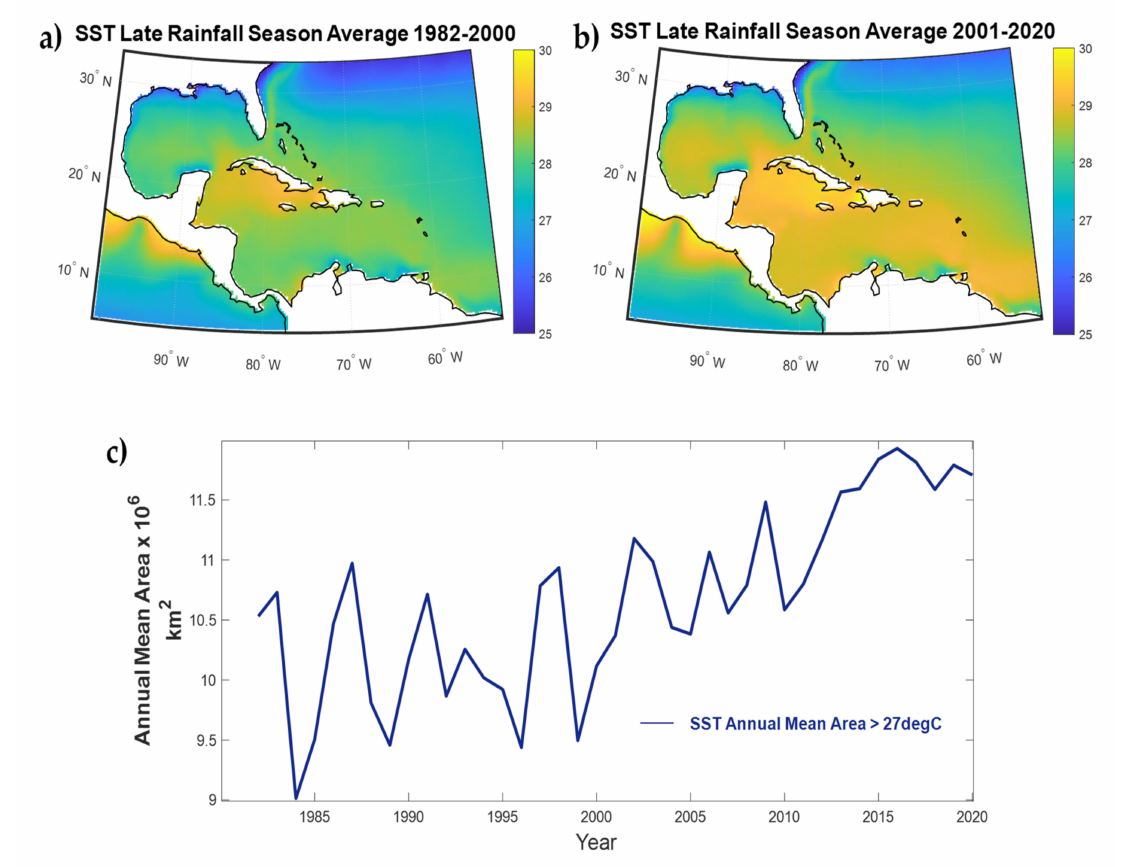
Figure 4. Late Rainfall Season sea surface temperature averages for warming SST observation: ( a ) 1982–2000, ( b ) 2001–2020, and ( c ) convection threshold Area Index time series for the Caribbean and surrounding region. The color bar indicates the temperature ( ◦ C).